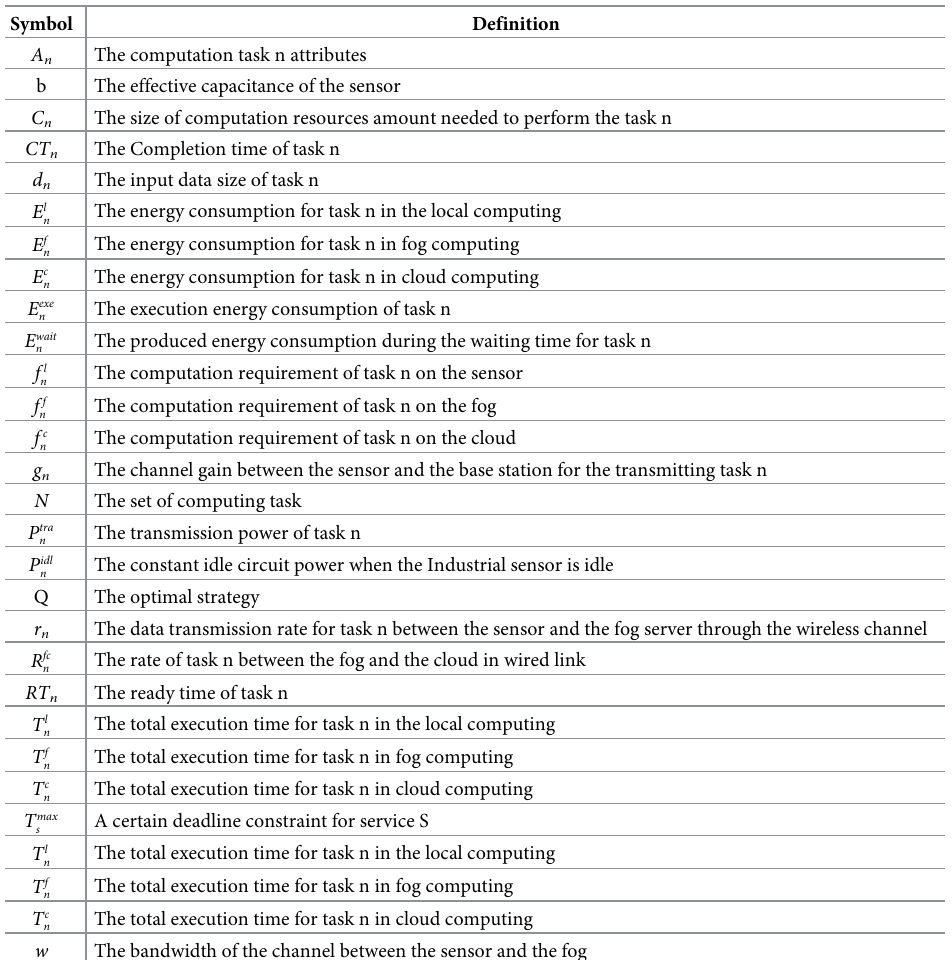
Table 1. List of